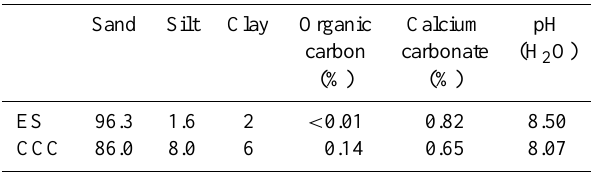
Table 1. Soil parameters of the experimental site (ES) and the Chicken Creek Catchment